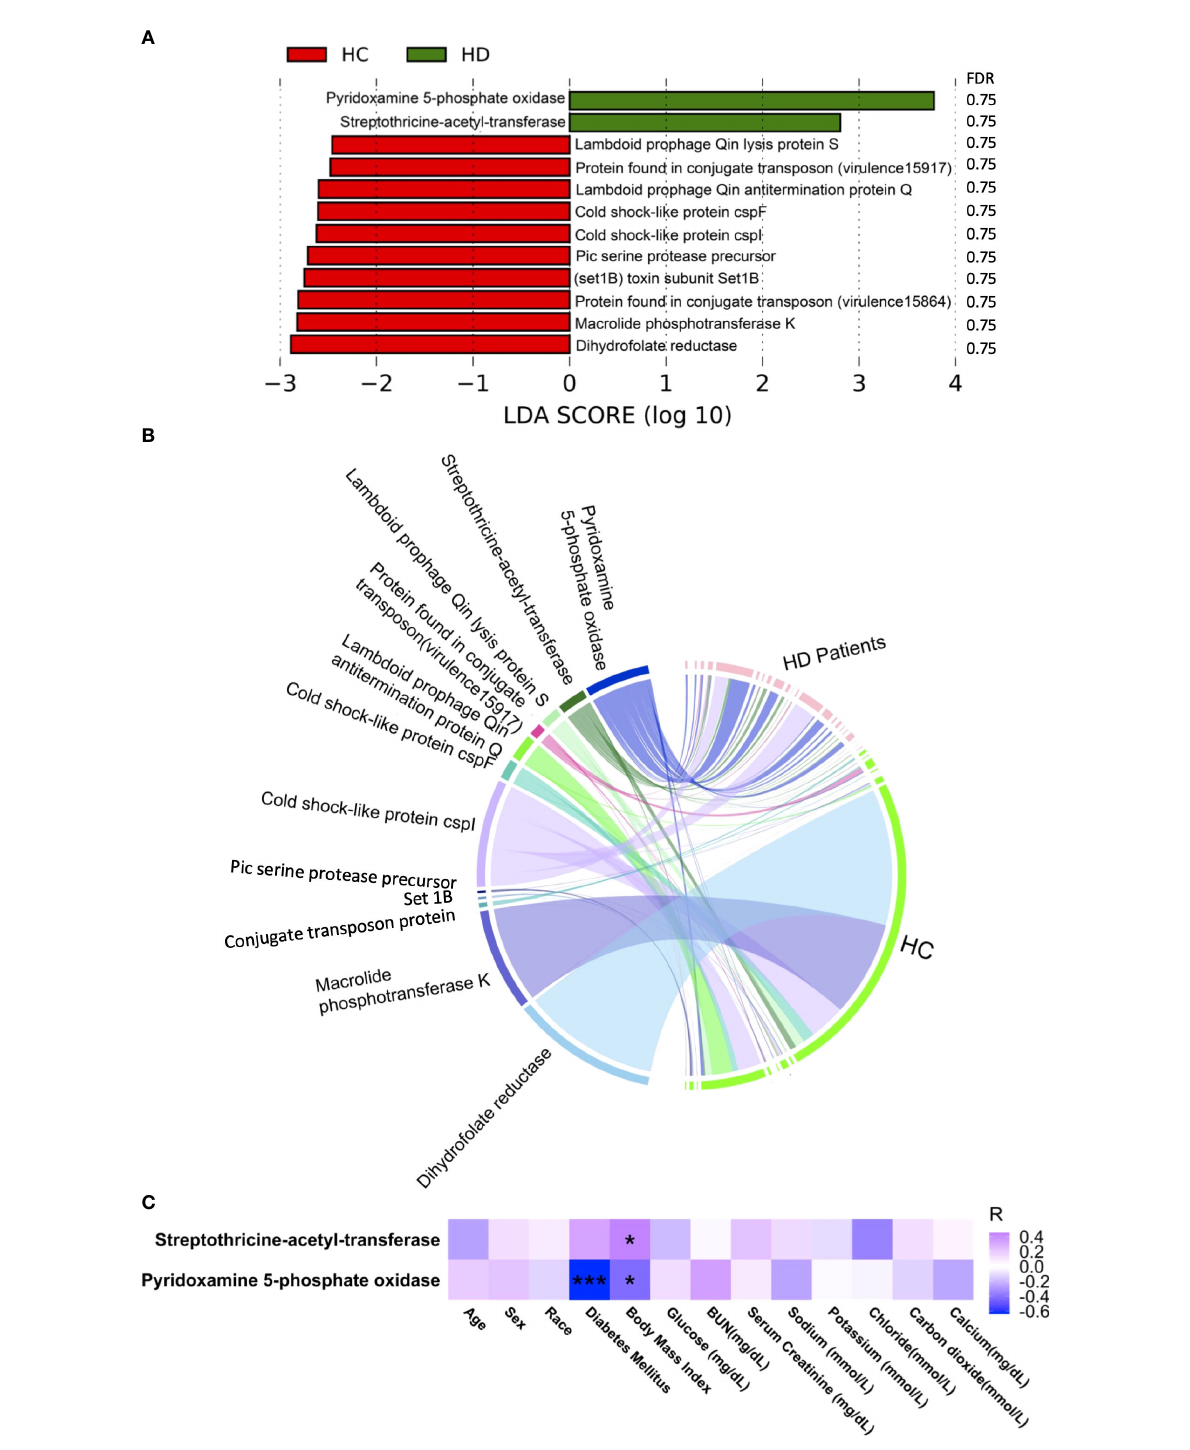
FIGURE 4 Alterations in antibiotic resistance factors. (A) Signi fi cantly altered antibiotic resistance factors between HD patients and control subjects. (B) Distribution of antibiotic resistance factors in each sample. Data were visualized via Circlize package in R. (C) Correlations between antibiotic resistance factors and clinical data. * p -value < 0.05; *** p -value < 0.001. BUN, blood urea